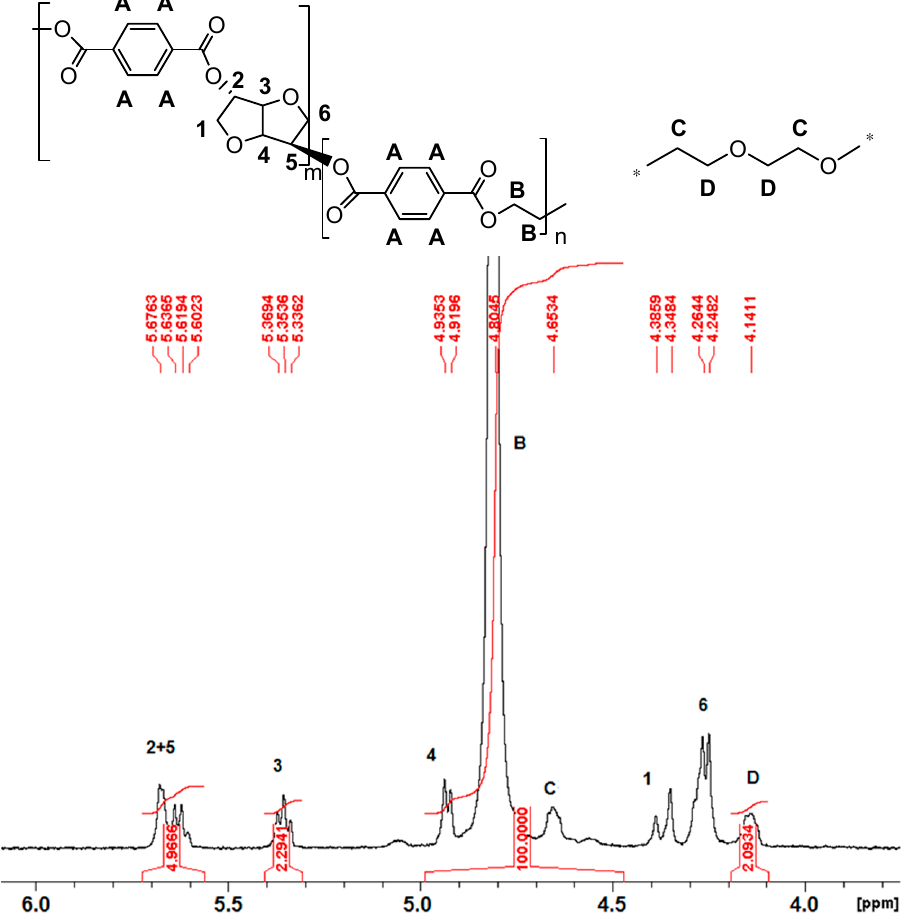
Figure 1. NMR spectra of a typical poly(ethylene terephthalate- co -isosorbide terephthalate) PEIT (entry 2) in the 4–6 ppm zone and assignments.